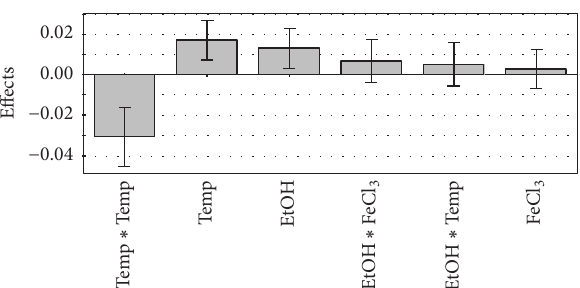
Figure 2: The effects of precipitation agents and temperature on recovery of resoluble proteins from potato. The scaled effects of the model terms are presented at 95% confidence level. Temp: temperature, EtOH: ethanol concentration, FeCl 3 : FeCl 3 concen- tration, Temp ∗ Temp: square term of temperature, EtOH ∗ FeCl 3 : interaction term of ethanol and FeCl 3 , and EtOH ∗ Temp: interaction term of ethanol and temperature.